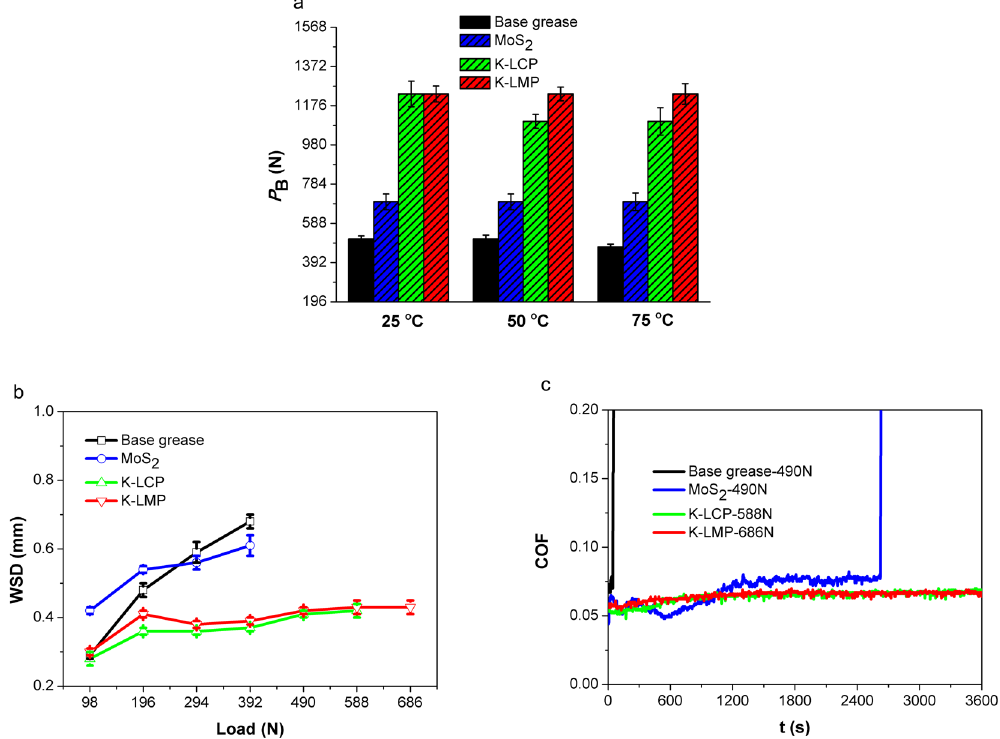
Figure 6. Friction and wear performance of layered potassium magnesium and calcium phosphates as additives in coconut oil calcium-based grease. ( a ) P B values at different temperature (25, 75 and 120 °C). ( b ) WSD values under different loads (from 98 to 686 N). ( c ) Dynamic friction curves under maximum applied loads (K-LMP 686 N, K-LCP 588 N, MoS 2 490 N, Base grease 490 N). Test conditions: four-ball test, P B : 1770 rpm, 10 s; WSD/ COF: 75 °C, 1200 rpm, 3600